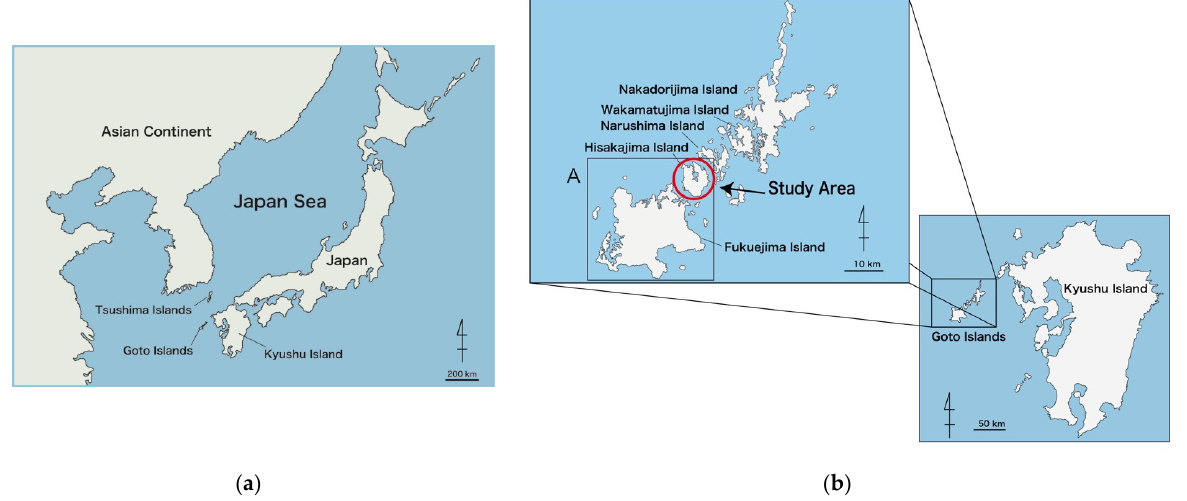
Figure 1. Location of the study area — ( a ) Location of the Tsushima and Goto Islands; and ( b ) enlarged map of the Hisakajima and Fukuejima Island region.